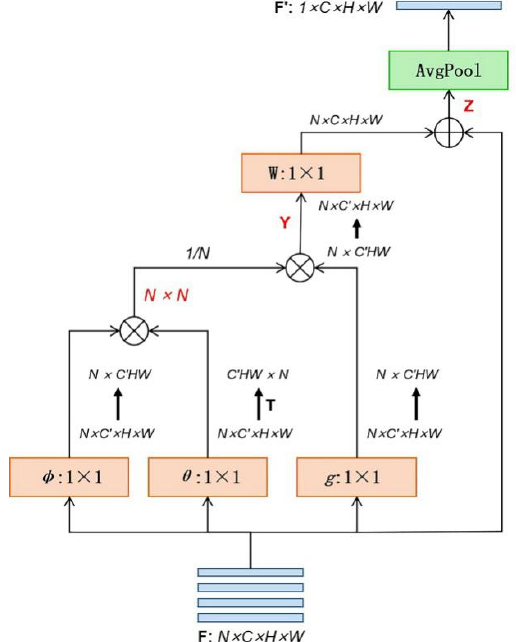
Figure 4. Description of non-local temporal attention (NLTP). The size of the input feature maps F is N × C × H × W (N represents the number of frames included in the input video, C is the number of channels of each frame feature map, and H and W indicate the height and width of the input feature map, respectively). The symbol ‘T’ stands for the transpose function. ‘1/ N ’ is used for normalization. ‘ ⊕ ’ denotes the addition operation based on elementwise. ‘ ⊗ ’ denotes matrix multiplication. The yellow box defines four different 1 × 1 convolution blocks. We used the dot product method to calculate the attention score and generate an N × N attention matrix.